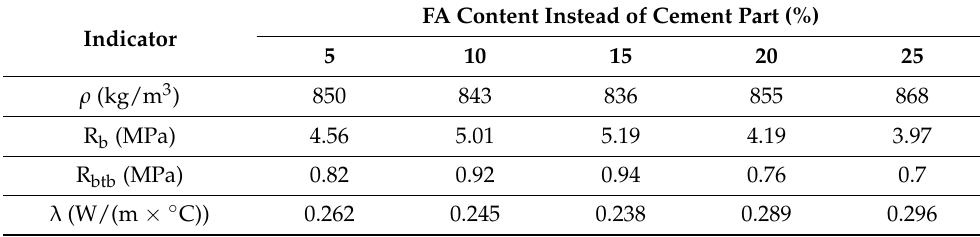
Table 11. Physical and mechanical characteristics of samples of non-autoclaved aerated concrete modified with